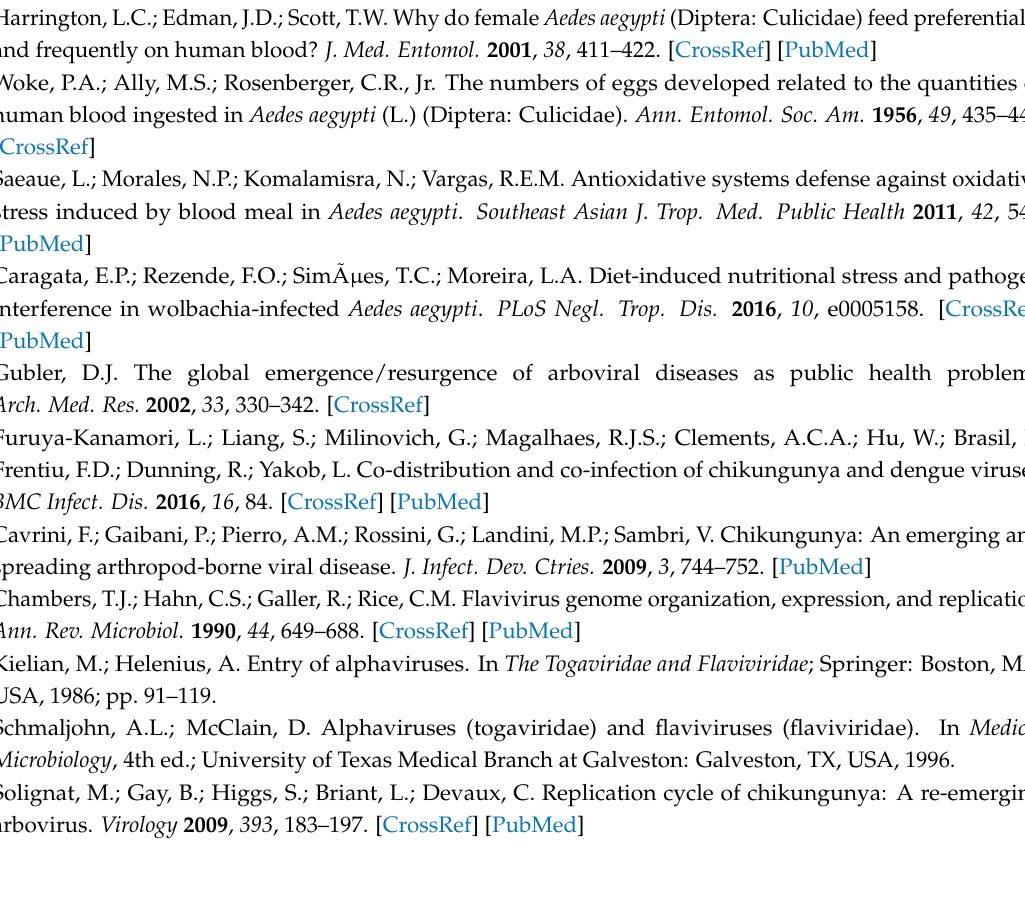
Figure S1. Workflow followed in the study; Figure S2. Intensity of metabolites before and after normalization; Figure S3. Graphical representation of ANOVA results; Figure S4. Pair-wise score plots showing the variance: (a) PCA analysis and (b) PLS-DA analysis; Figure S5. PCA (a), (c), (e) and PLS-DA (b), (d), (f) plots pair-wise analysis of CHIKV, DENV, and co-infected samples, respectively; Figure S6. Significantly regulated pathways of proteomics data upon CHIKV and DENV infection in (a) midgut and (b) salivary gland of mosquito. Table S1. List of all genes, proteins and metabolites from this study related to oxidative stress pathways Author Contributions: S.S. and N.S.B. conceived and designed the experiments; J.S. performed the experiments; J.S., S.S. and N.S.B. analyzed the data; J.S., S.S. and N.S.B. wrote the